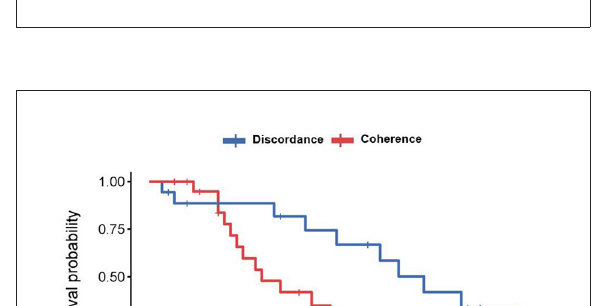
FIGURE1 Subtype conversion between the brain metastatic lesions and primary lesions in patients with breast cancer.